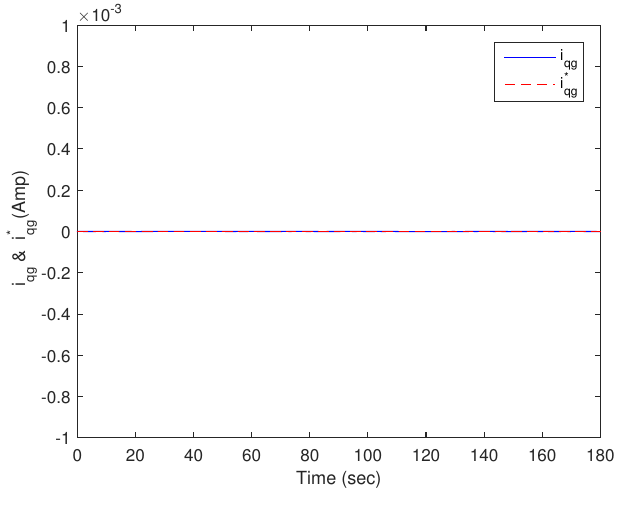
Figure 14. The currents i qg and i ∗ qg versus time.